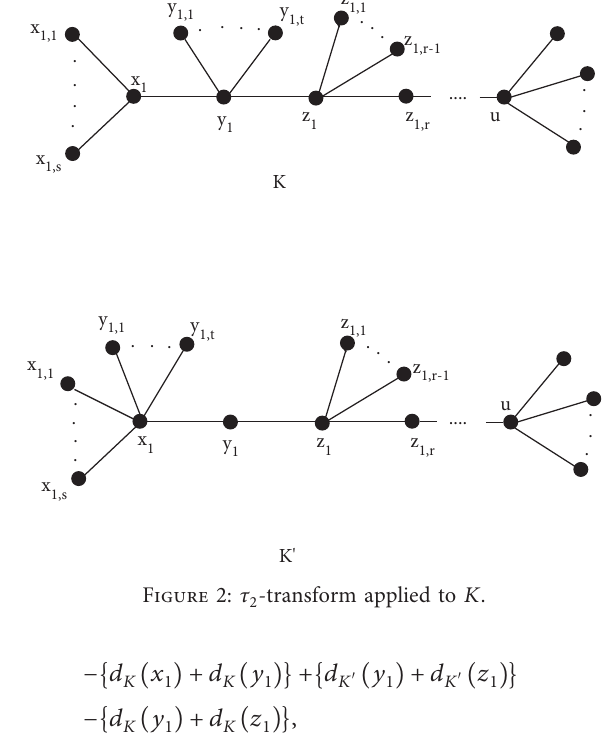
Figure 2: τ -transform applied to K 2